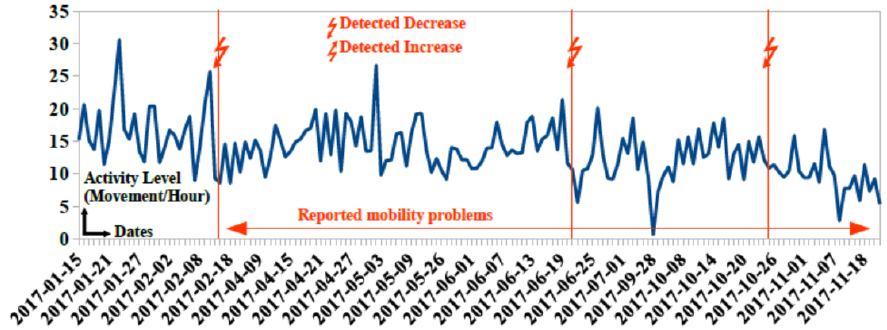
Figure 5. Detected changes in activity level of participant 91 due to mobility